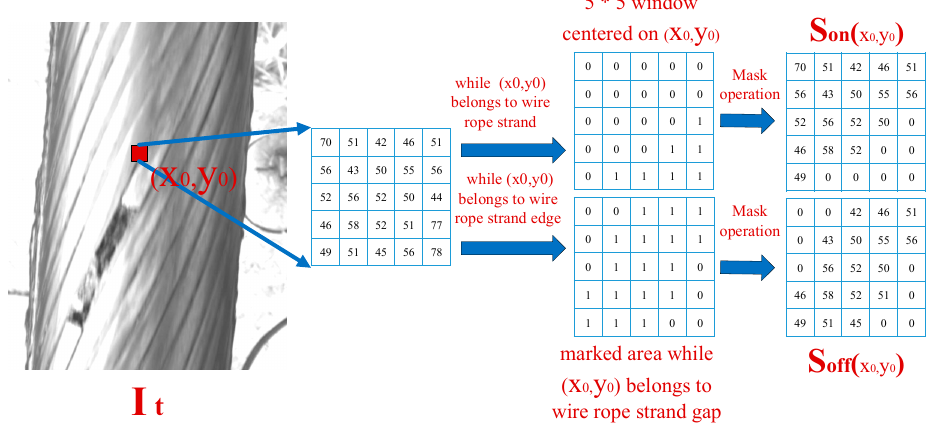
Figure 10. Composition of the spatial gray sample set.